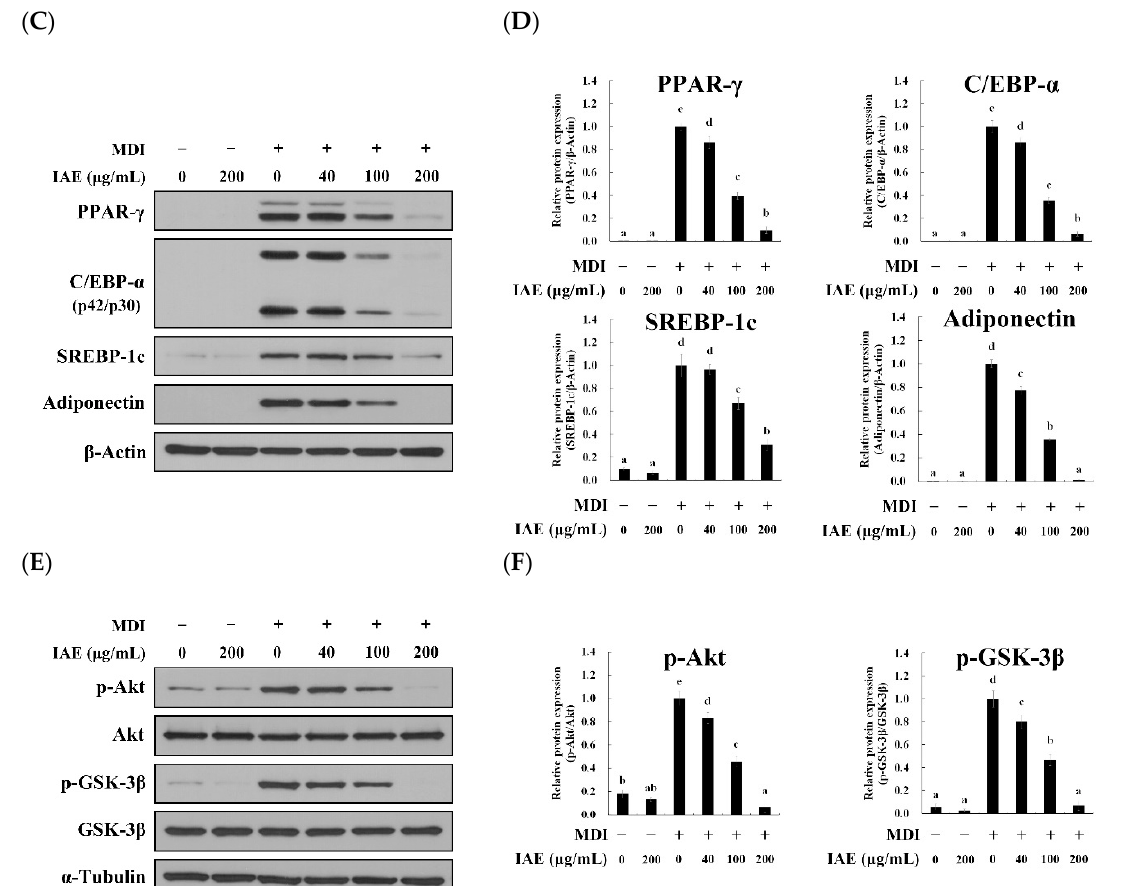
Figure 2. Inula britannica flower aqueous extract (IAE) exerts anti-adipogenic effects in MDI-induced differentiation of 3T3-L1 preadipocytes involving regulation of Akt/GSK-3 β signaling pathways. The cells were differentiated for eight days with the indicated concentrations of IAE. The phosphorylation of Akt (Ser 473) and GSK-3 β (Ser21/9) was examined to evaluate the activation of the Akt/GSK-3 β signaling pathways. The protein expression levels of adipogenesis-associated biomarkers were determined by using western blotting. ( A ) Protein expression levels of lipogenesis-associated biomarkers. ( B ) Relative protein expression levels of lipogenesis-associated biomarkers. ( C ) Protein expression levels of adipogenesis-specific biomarkers. ( D ) Relative protein expression levels of adipogenesis-specific biomarkers. ( E ) E ff ect of IAE on the activation of Akt / GSK-3 β signaling pathways. ( F ) Relative protein expression levels of phosphorylated Akt and GSK-3 β . The data are presented as mean ± standard deviation. Values labeled with di ff erent letters (a–e) are significantly di ff erent ( p < 0.05). Di ff erences among the multiple groups were determined based on one-tailed one-way analysis of variance, followed by Tukey’s post hoc test.